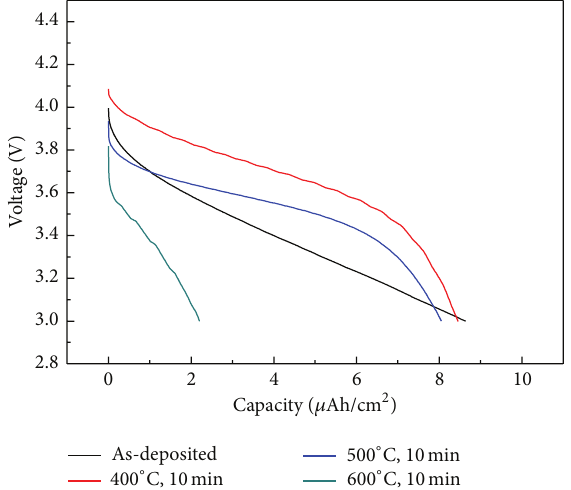
Figure 4: Initial discharge curves of LiNiO 2 thin film with various annealing temperatures. The annealing time was 10